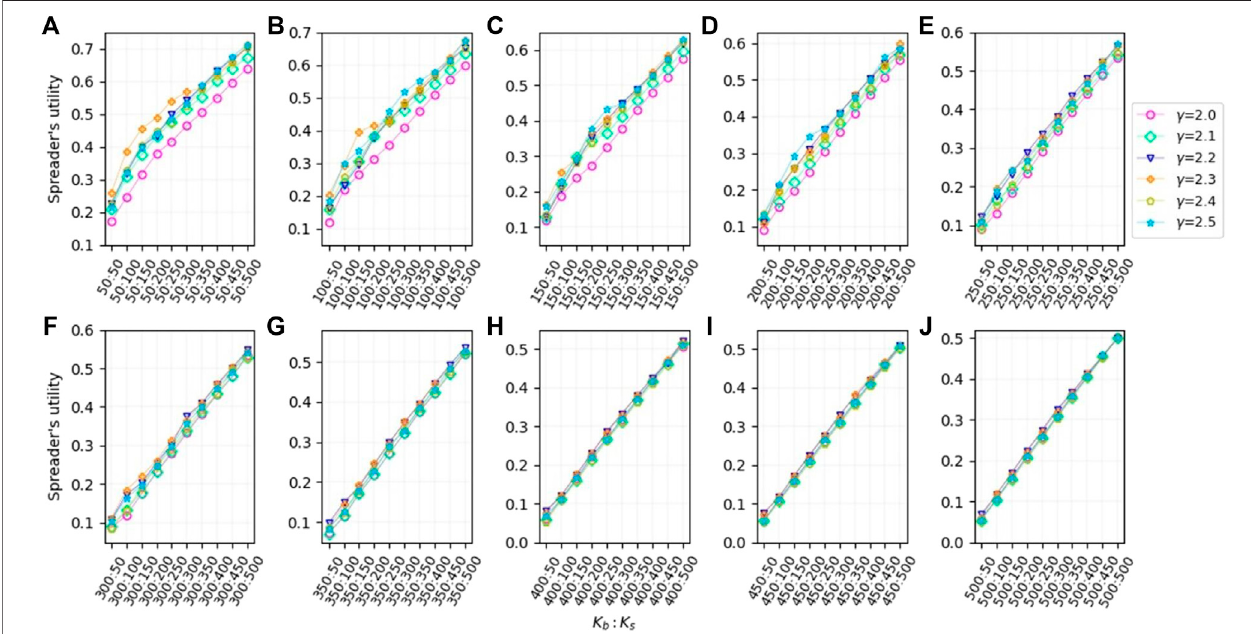
FIGURE 6 | Plot of the growth ofequilibrium gain values for different numbers ofblocker ’ s seed nodes K b on scale-free networkswith different power exponents γ as the number of spreader ’ s seed nodes K s increases. (A) K b = 50; (B) K b = 100; (C) K b = 150; (D) K b = 200; (E) K b = 250; (F) K b = 300; (G) K b = 350; (H) K b = 400; (I) K b = 450; (J) K b = 500.